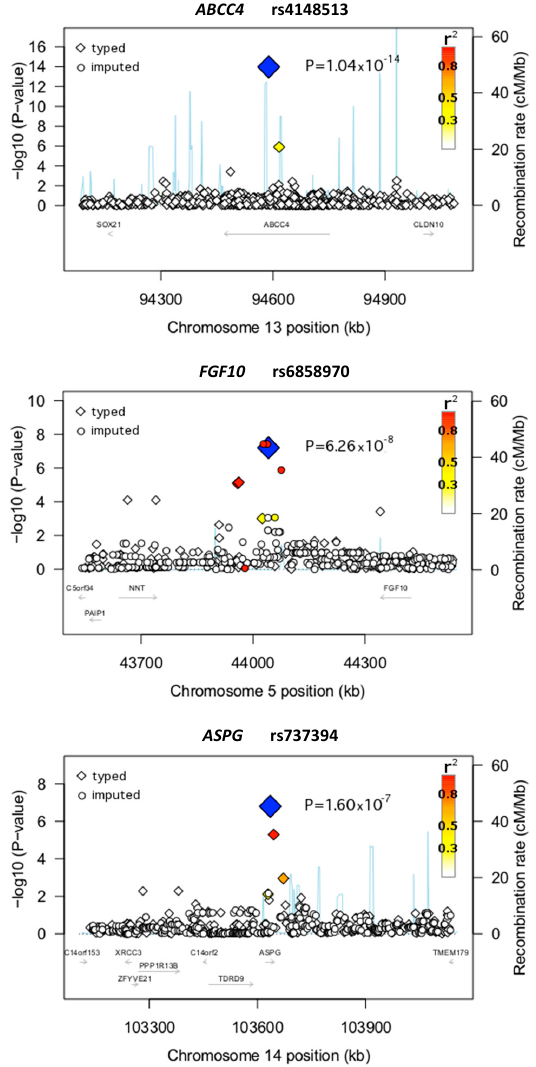
Figure 1. Regional plots of the loci ABCC4 , FGF10 , and ASPG . Plots of the negative decadic logarithm of the combined p ‐ values obtained in the GWAS are shown. The data were imputed with CEU haplotypes generated by the 1000 Genomes Project (August 2010 release) as a reference. A window of ±500 kb around the lead SNVs (blue solid diamonds) is indicated. The magnitude of the linkage disequilibrium with the central SNV measured by r 2 is reflected by the color of each SNV symbol (color coding: see the upper ‐ right corner of the plot). Recombination activity (in centimorgans (cM) per Mb) is depicted by a blue line. Positions are given as NCBI’s build coordinates.